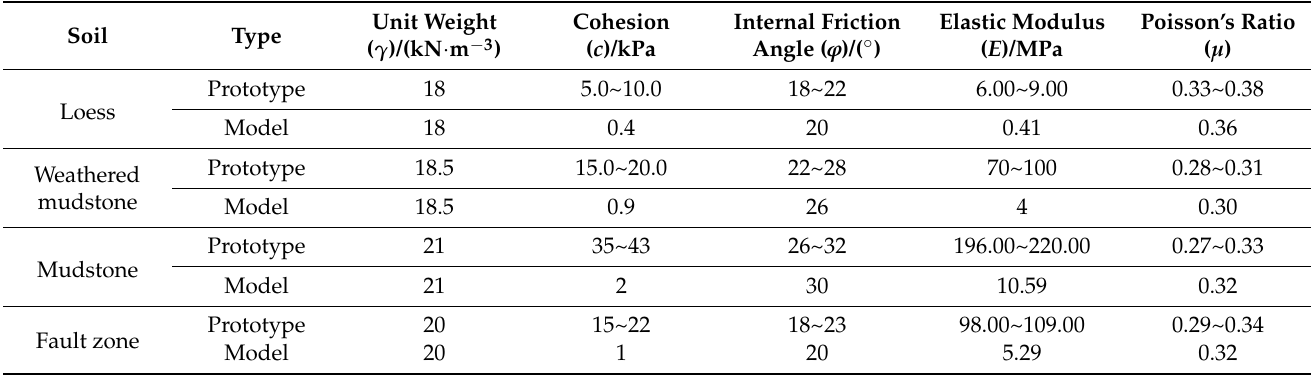
Table 4. The values of primary parameters of prototype and model strata [6].